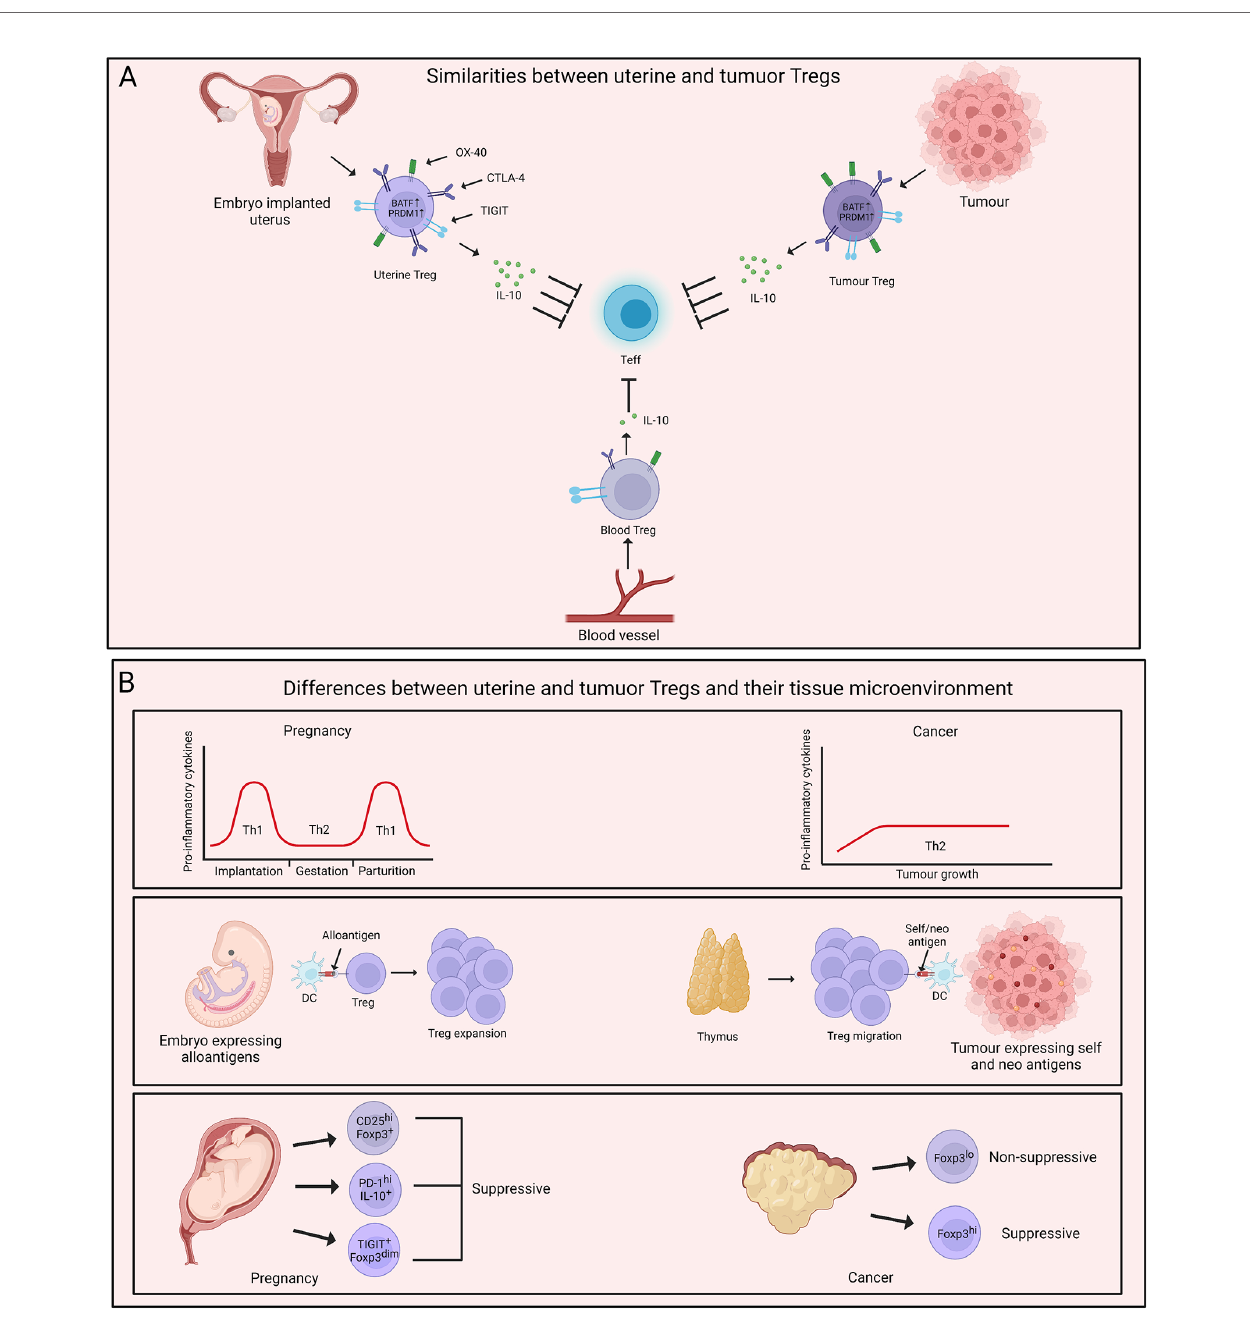
FIGURE 2 | Parallels and dissimilarities between uterine and tumour Tregs. (A) Uterine Tregs display several tissue adaptations which mimic tumour Tregs. Both uterine and tumour Tregs are characterised by higher expression of BATF and PRDM1. These cells also demonstrate increased suppressive abilities with elevated levels of IL-10 in comparison to their blood counterparts. Uterine and tumour Tregs exhibit an effector phenotype with increased expression of molecules such as TIGIT, PD-1, OX-40, CTLA-4 and CD25. (B) A major difference between uterus and tumour microenvironment is in fl ammatory milieu of these two tissues. Uterine microenvironment oscillates between T helper type 1 (Th1) and Th2 during pregnancy while tumour growth is fostered by Th2-polarised microenvironment. Uterine Tregs respond to ‘ paternal non-self ’ and ‘ maternal self ’ antigens and expand locally. On the contrary, thymus-derived Tregs populate tumour and are exposed to self- and neo-tumour antigens. Uterine and tumour Tregs display phenotypic and functional heterogeneity with uterine Treg subtypes being majorly immune- suppressive while tumour Tregs being both suppressive and non-suppressive. Created with